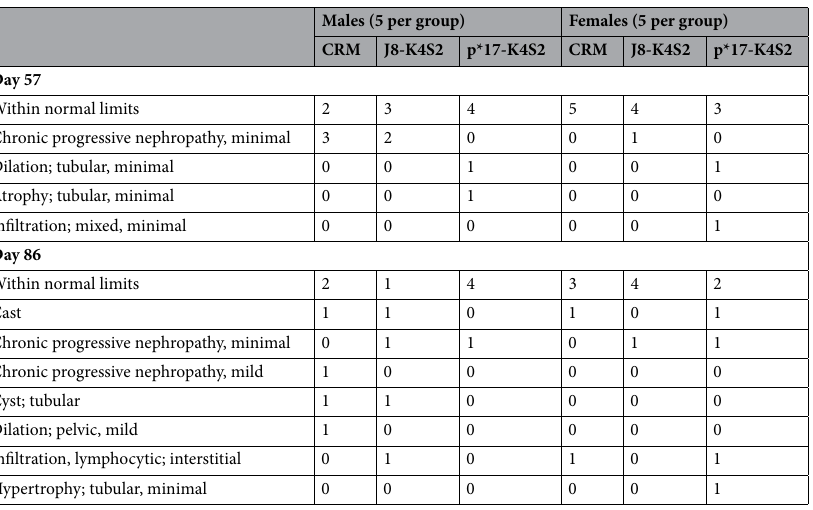
Table 2. Kidneys—histopathology observations. CRM, CRM/Alum; J8-K4S2, J8-CRM + K4S2-CRM/Alum; p*17-K4S2; p*17-CRM +